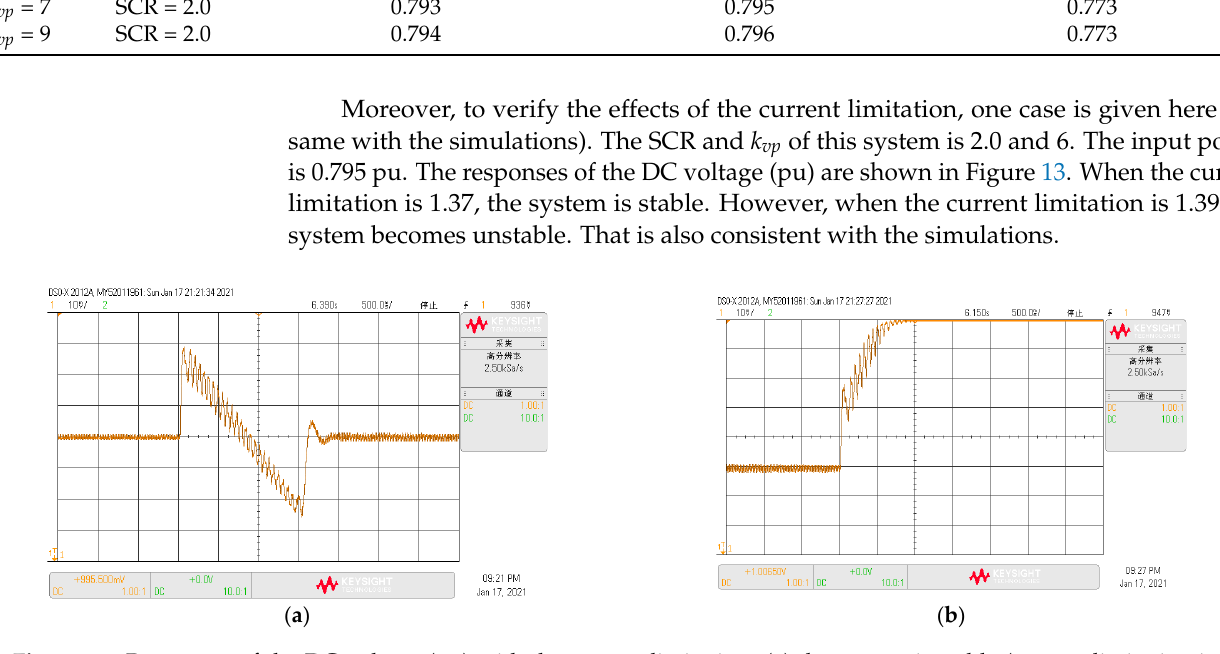
Figure 13. Responses of the DC voltage (pu) with the current limitation: ( a ) the system is stable (current limitation is 1.37 pu ); ( b ) the system is unstable (current limitation is 1.39 pu ).